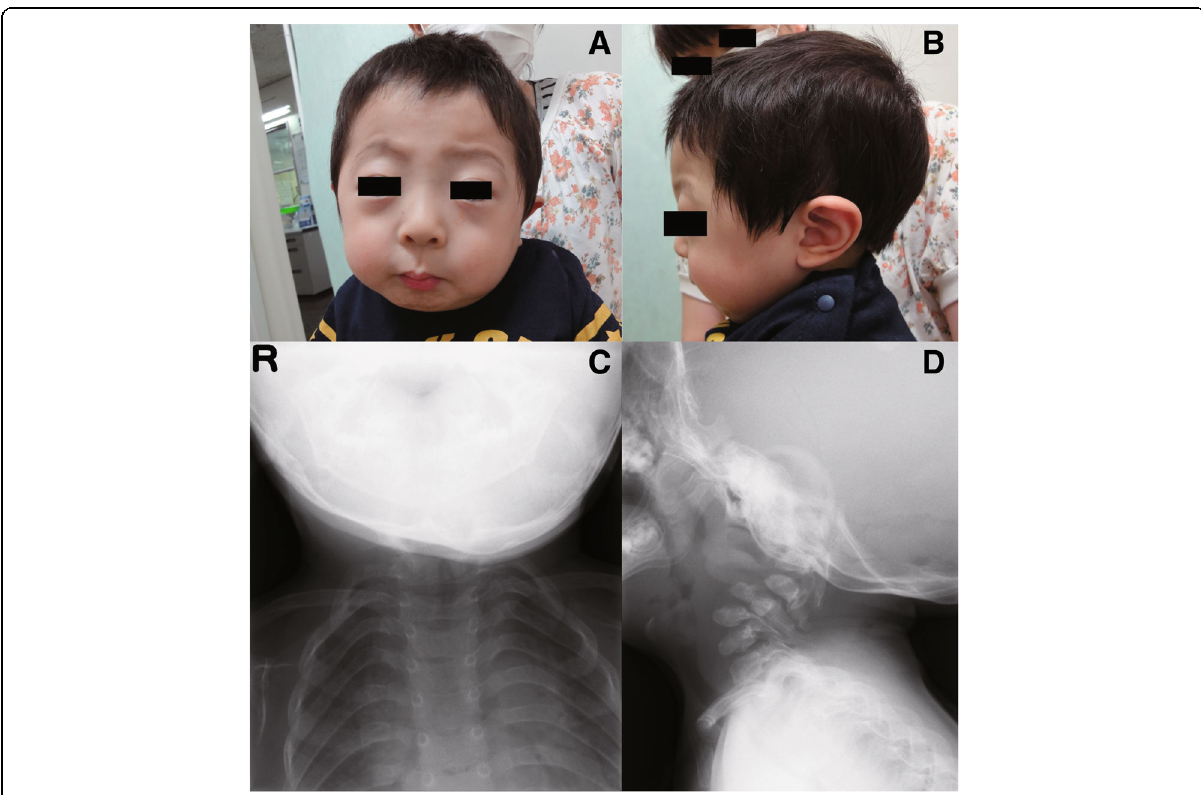
Fig. 2 Facial photographs and X-ray films of the patient. a , b The facial photographs show the typical facial features associated with Schwartz – Jampel syndrome. Fixed facial expression, micrognathia, and low-set ears. c , d X-ray films show cervical